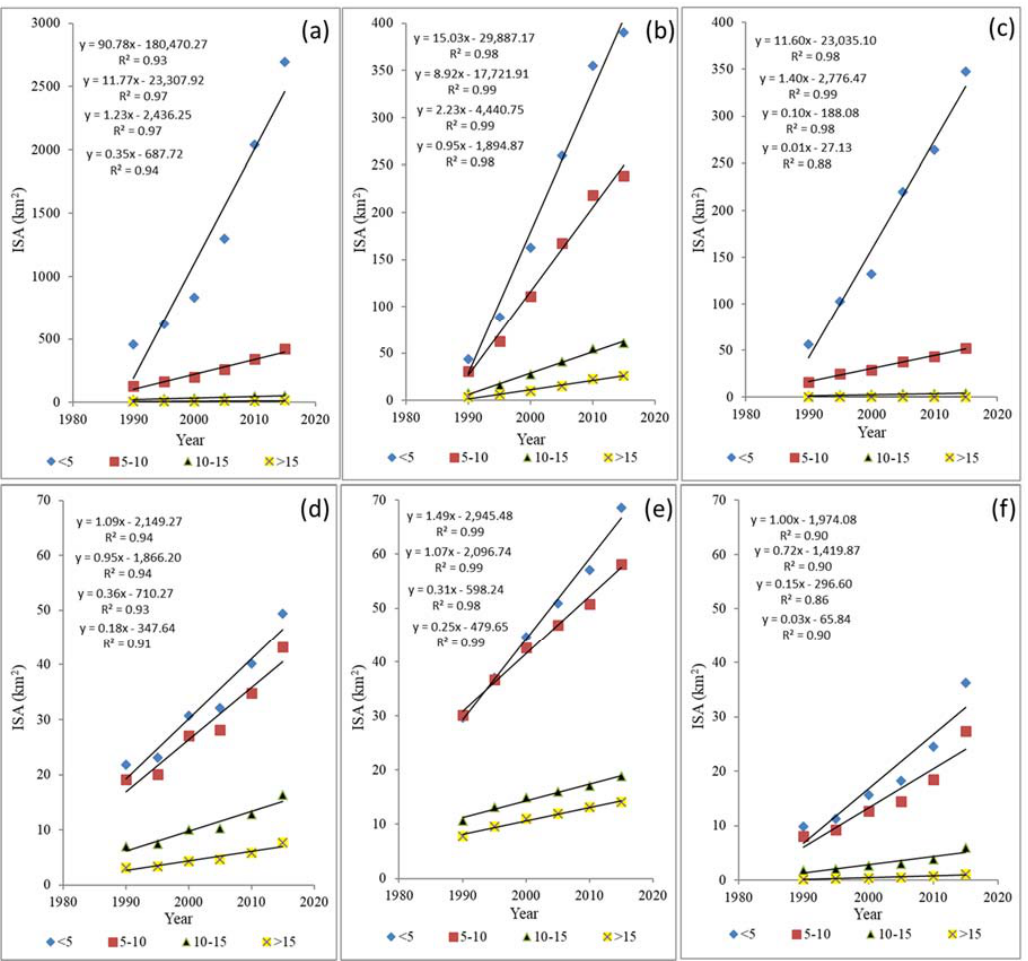
Figure 9. The change in ISA over time based on four slope categories; ( a ) Shanghai, ( b ) Shenzhen, ( c ) Ho Chi Minh City, ( d ) Ulaanbaatar, ( e ) Lanzhou, and ( f ) Vientiane.